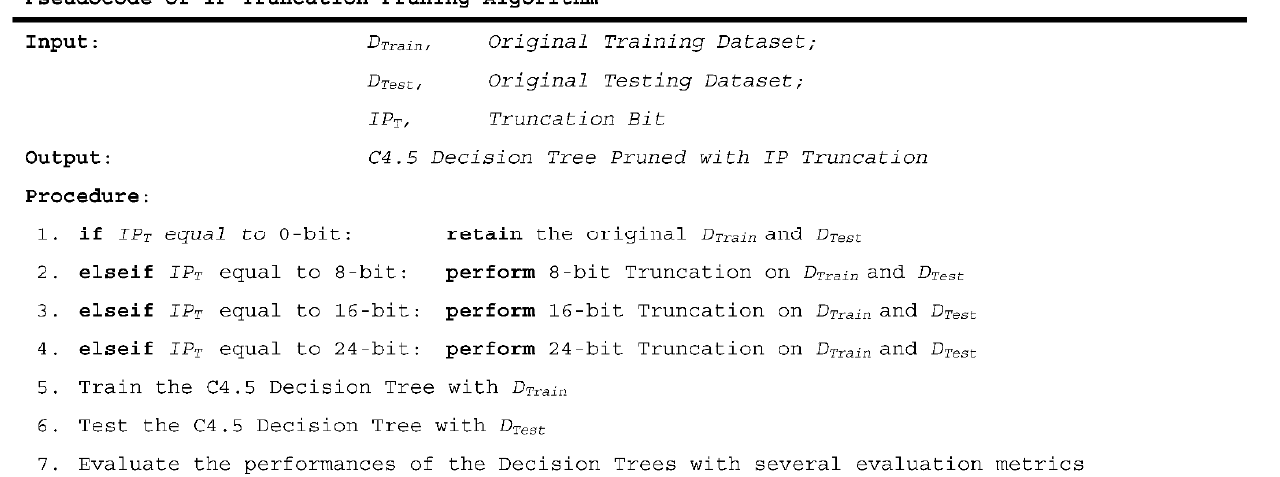
Figure 4. Pseudocode of the Proposed IP Truncation Pruning Algorithm.